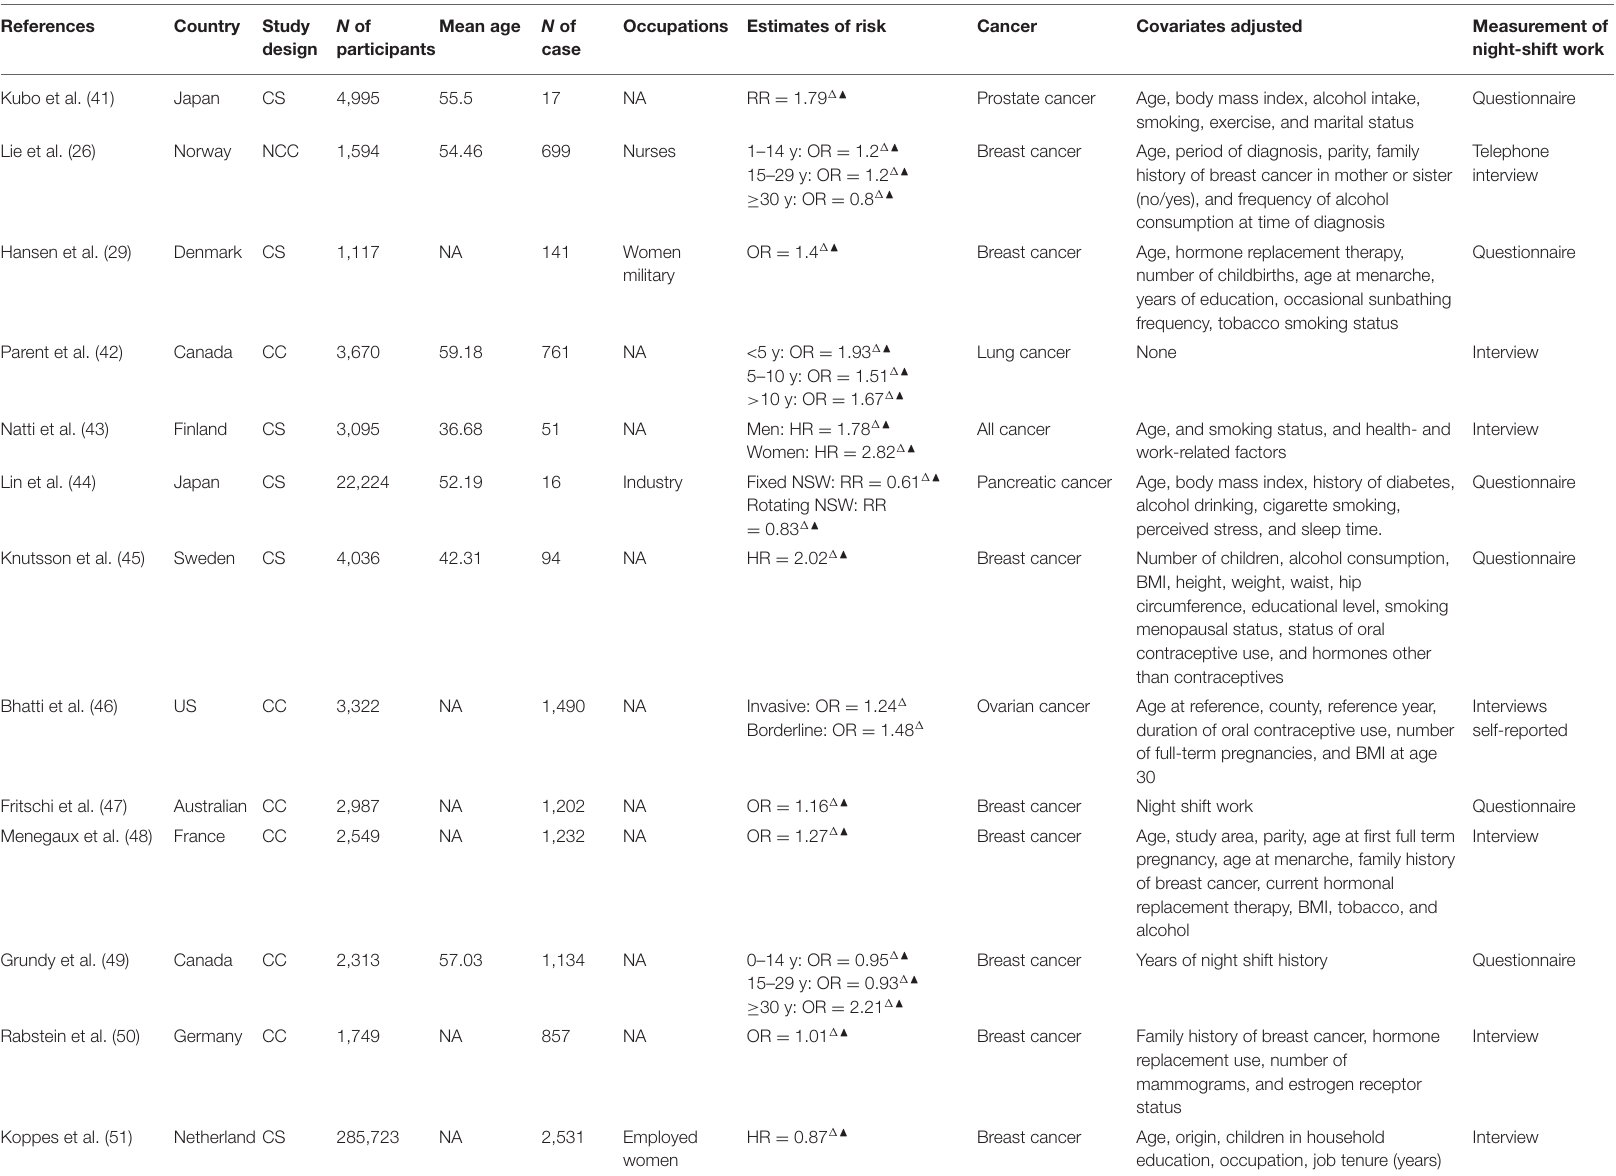
Breast cancer Age, study area, parity, age at first full term pregnancy, age at menarche, family history of breast cancer, current hormonal replacement therapy, BMI, tobacco,